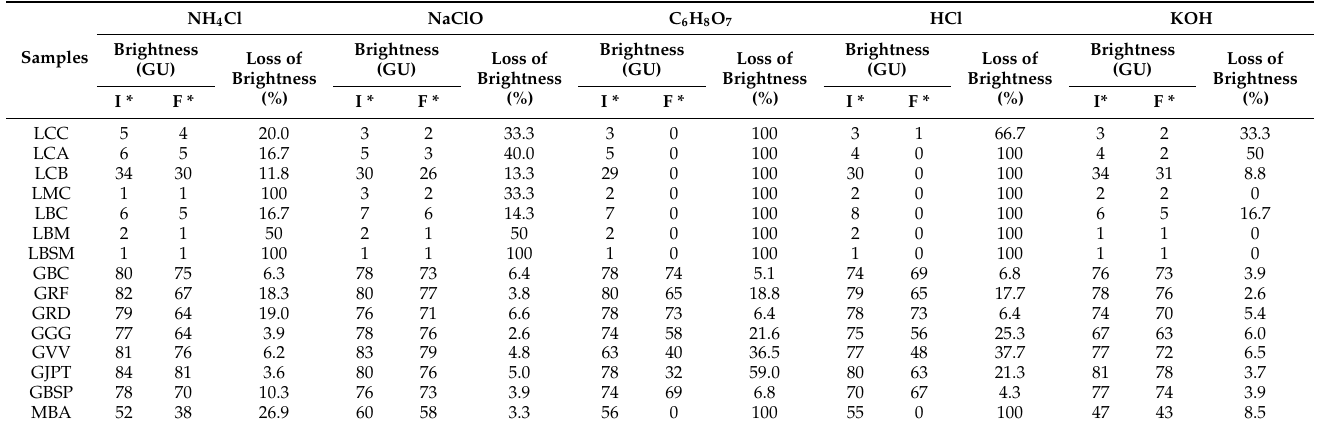
Table 8. Loss of brightness of samples after exposure to chemical